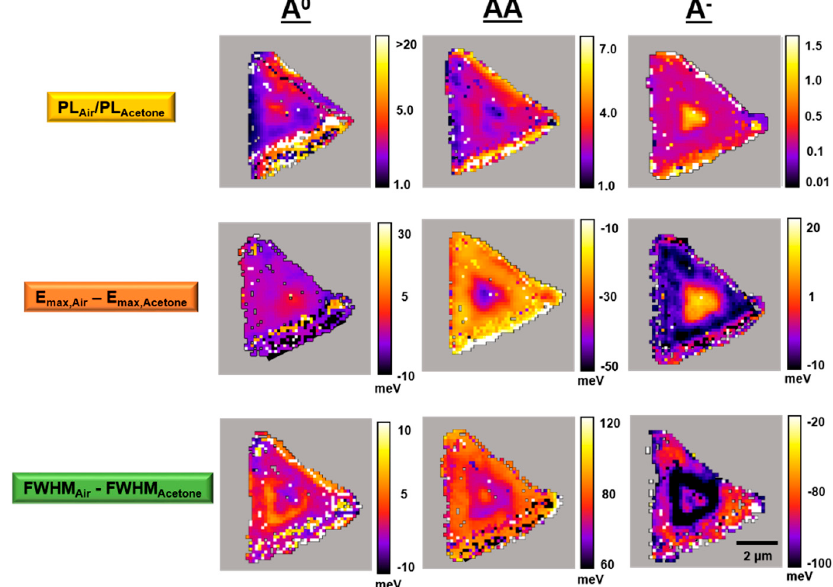
across the entire flake. ( a , b , c ) Maps in air. ( d , e , f ) Maps under acetone vapor.